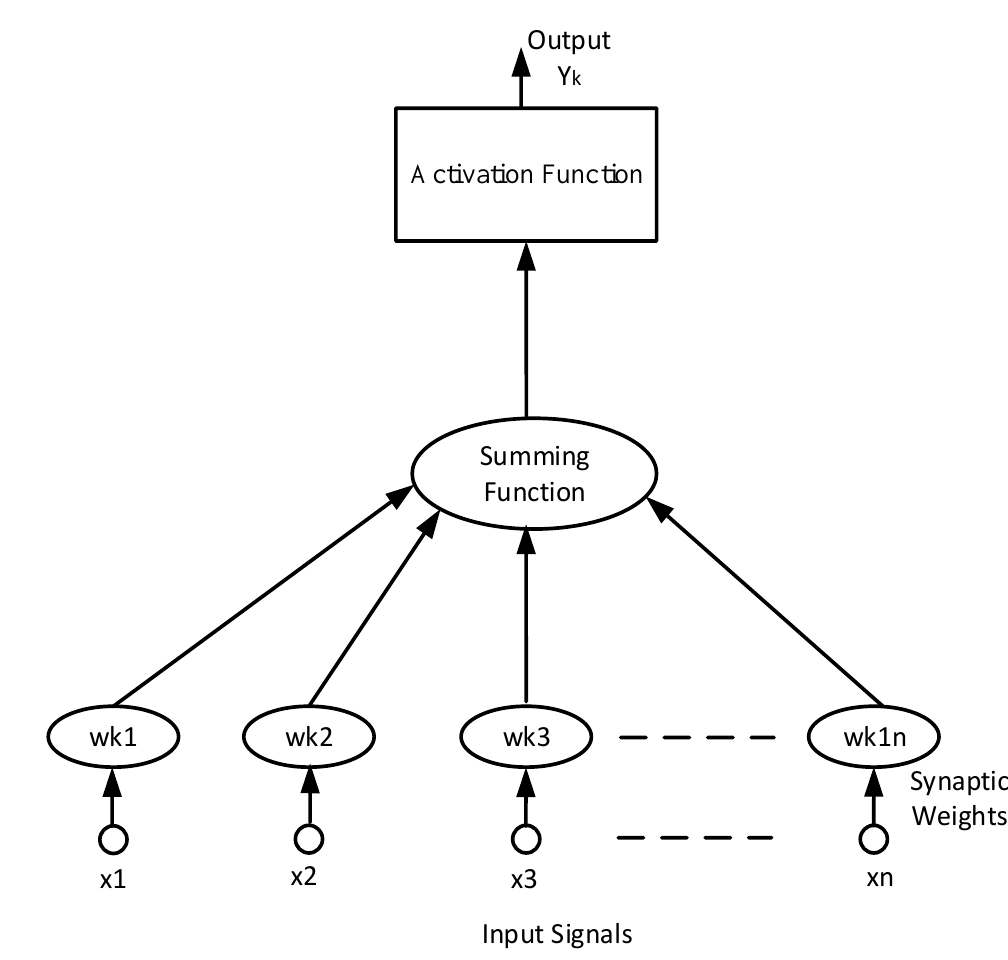
Figure 2. The architecture of the feedforward neural network (FFNN) [24,26,33].